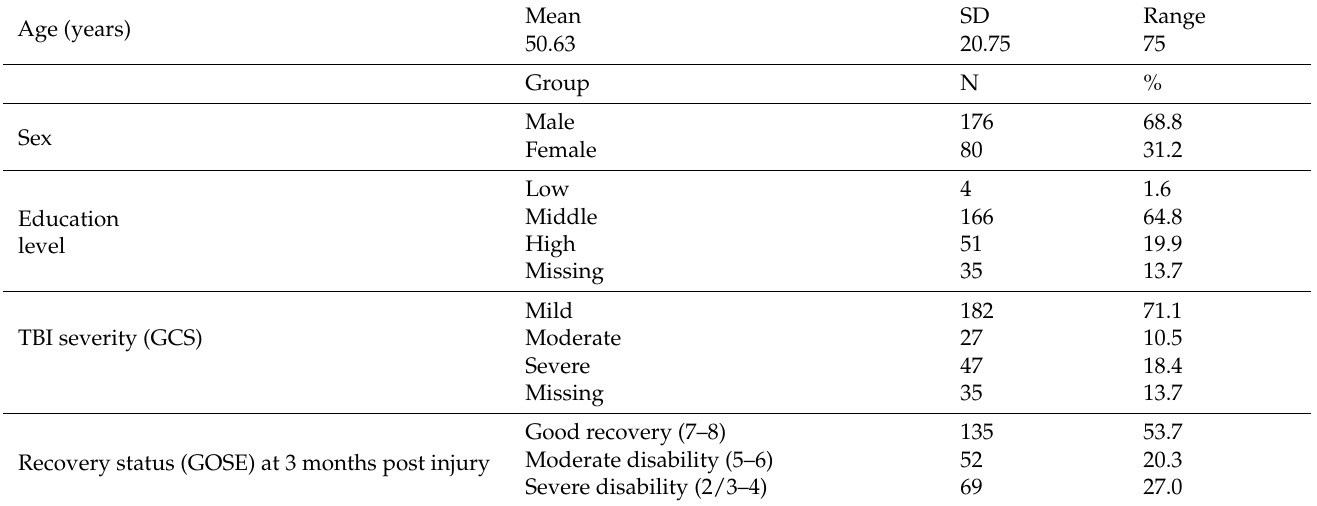
Table 2. Characteristics of the TBI sample (N =